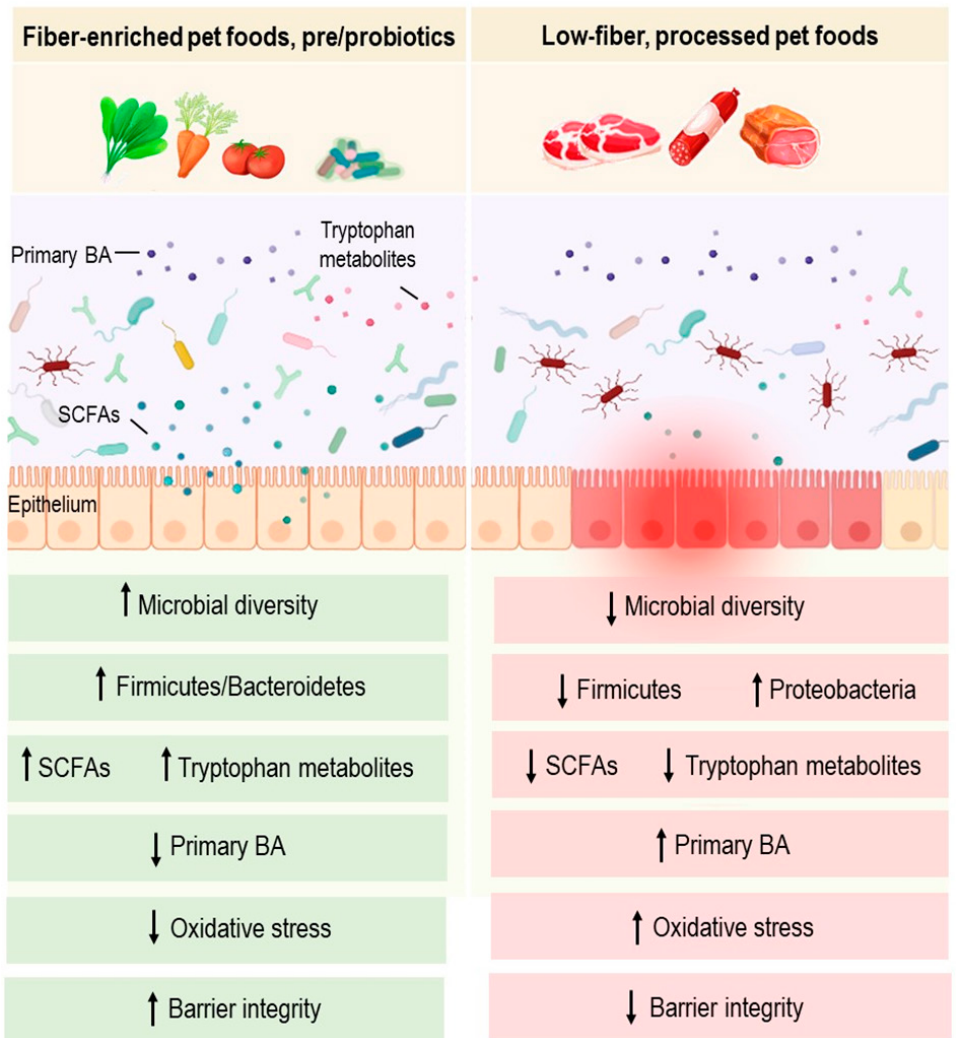
Figure 1. Overview of anti- and pro-inflammatory influences of dietary interventions in dogs. Die- tary patterns are linked with changes in the composition and function of the gut microbiota in dogs. Up and down arrows represent increases and decreases, respectively. SCFAs: short-chain fatty acids, BA: bile acids.